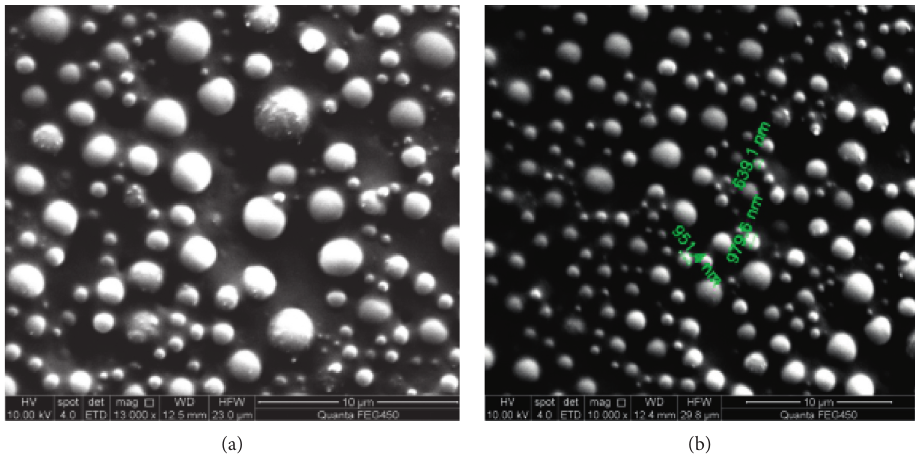
Figure 4: Low-magnification SEM image of the polymeric